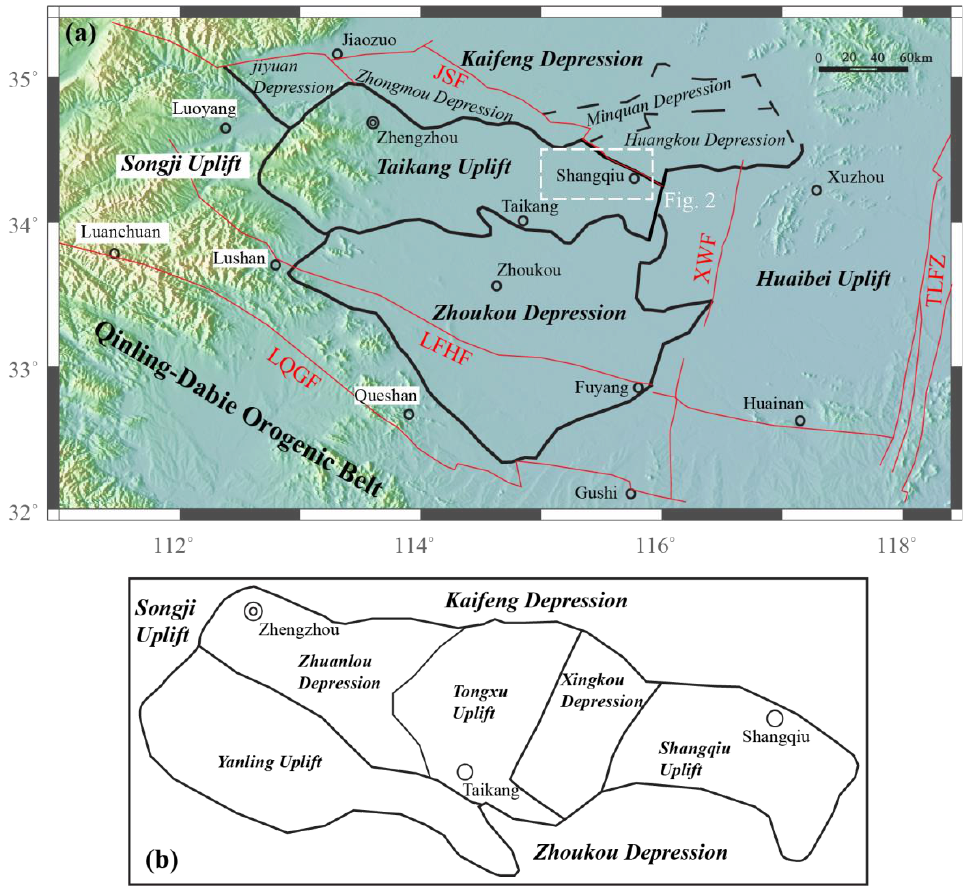
Figure 1. ( a ) Structural division map of the southern North China Basin. ( b ) Secondary structural division of the Taikang Uplift after [18]. JSF: Jiaozuo-Shangqiu fault, XWF: Xiayi-Woyang fault, LFHF: Lushan-Fuyang-Huainan fault, LQGF: Luanchuan-Queshan-Gushi fault, and TLFZ: Tanlu Fault Zone. Circles with Pinying names are cities in the study area. The dashed white rectangle is the study area shown in Figure 2.